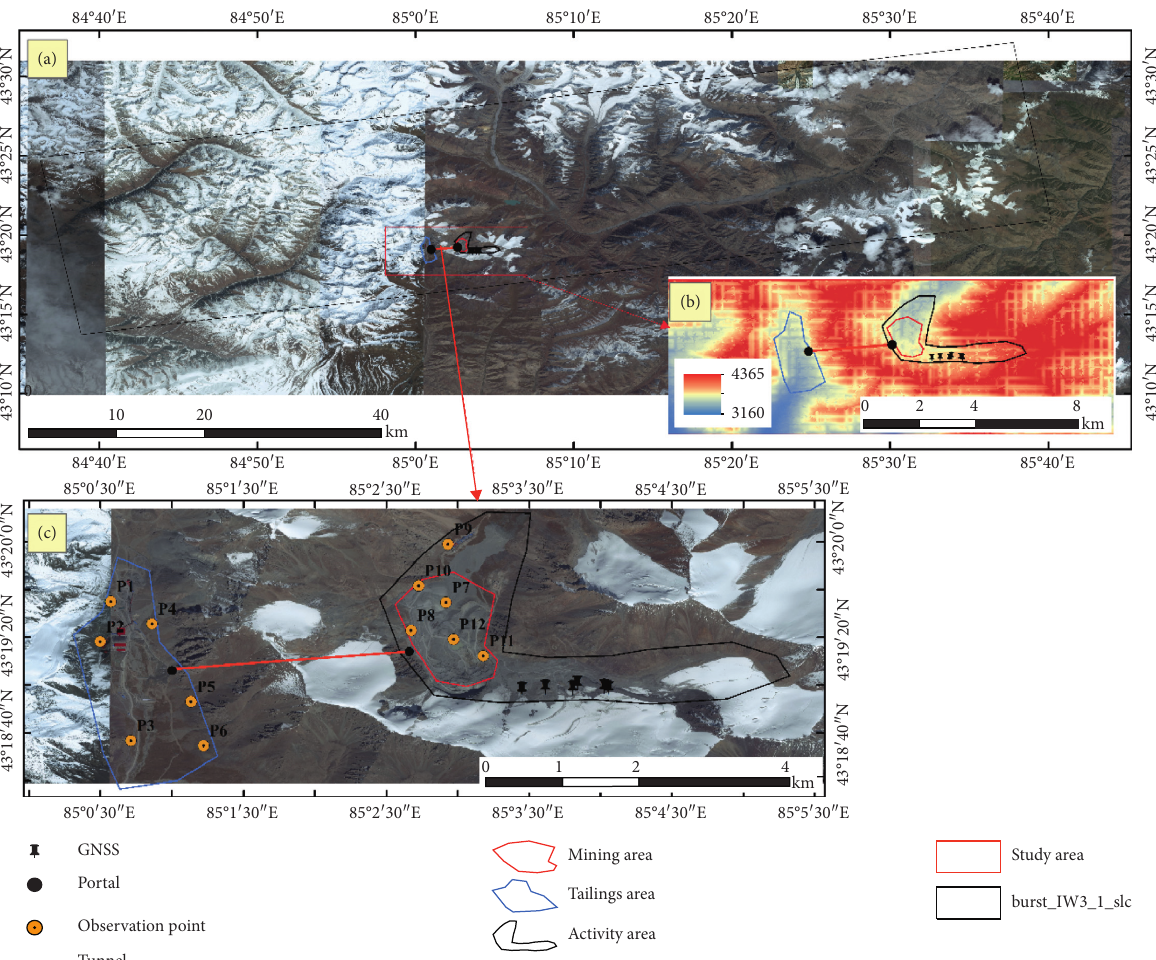
Figure 1: Geographical location of the study area: (a) position of the entire study area in the Sentinel-1A image; (b) DEM of the study area; (c) an enlarged view of the location of the mining area, observation points, and the GNSS